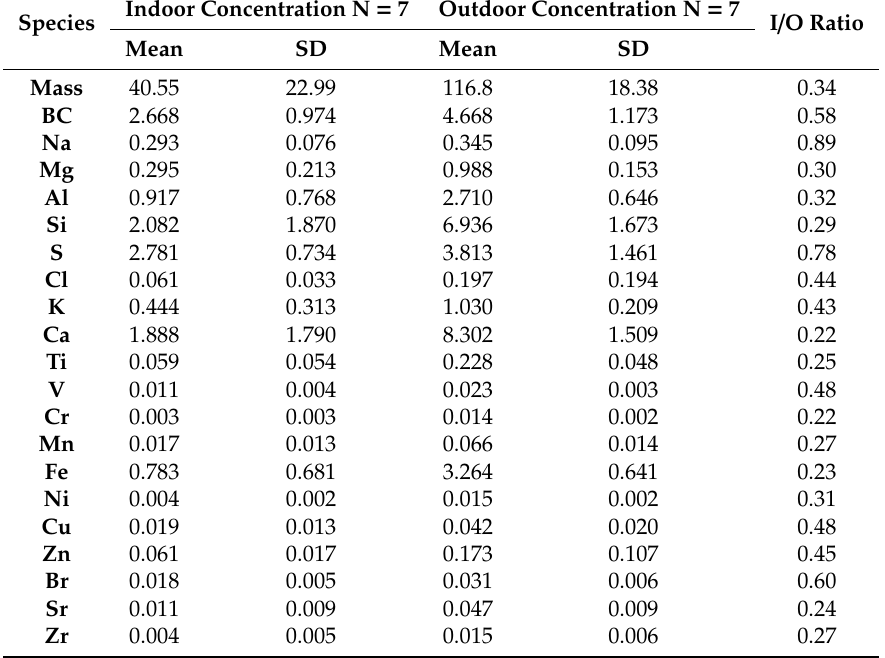
Table 2. Summary of means and standard deviations indoor and outdoor PM 10 mass and species concentrations and their I / O